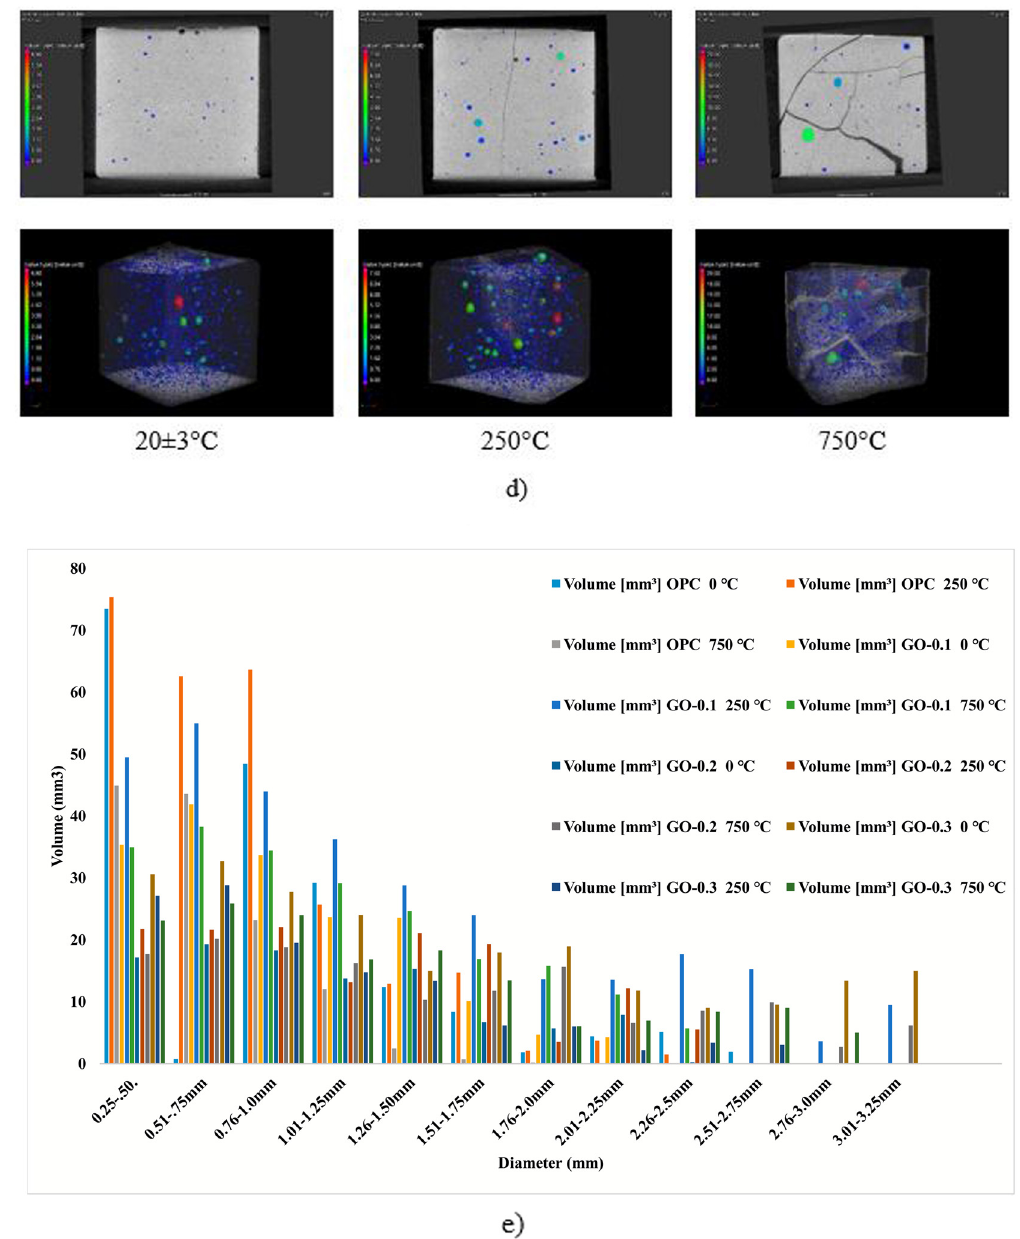
Figure 9: Micro - CT analysis before and after thermal exposure: ( a ) OPC, ( b ) GO - 0.1, ( c ) GO - 0.2, ( d ) GO - 0.3, and ( e ) porous void volumes by voids diameter